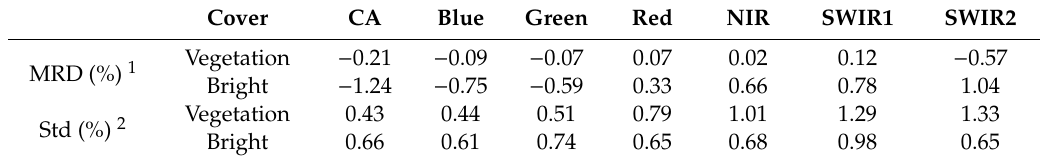
Table 5. Mean reflectance di ff erences for combined vegetation and bright ground truth sites. Cover CA Blue Green Red NIR SWIR1